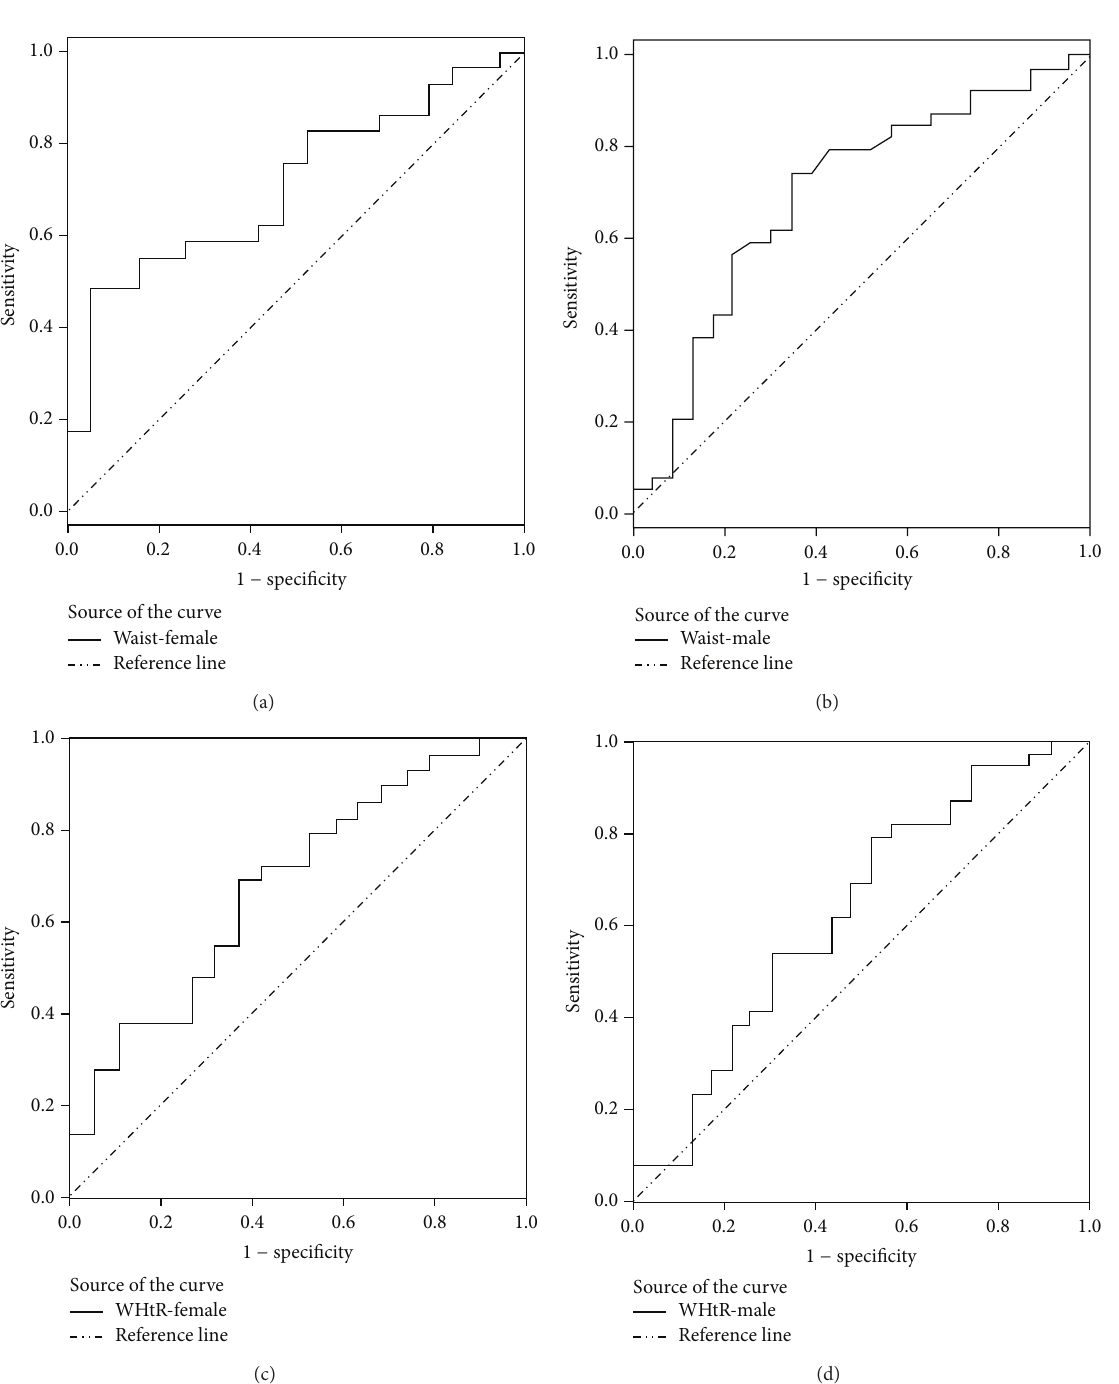
Figure 1: Receiver operating characteristic (ROC) curves for predicting metabolic syndrome by sex: (a) waist-female, (b) waist-male, (c) WHtR-female, and (d)